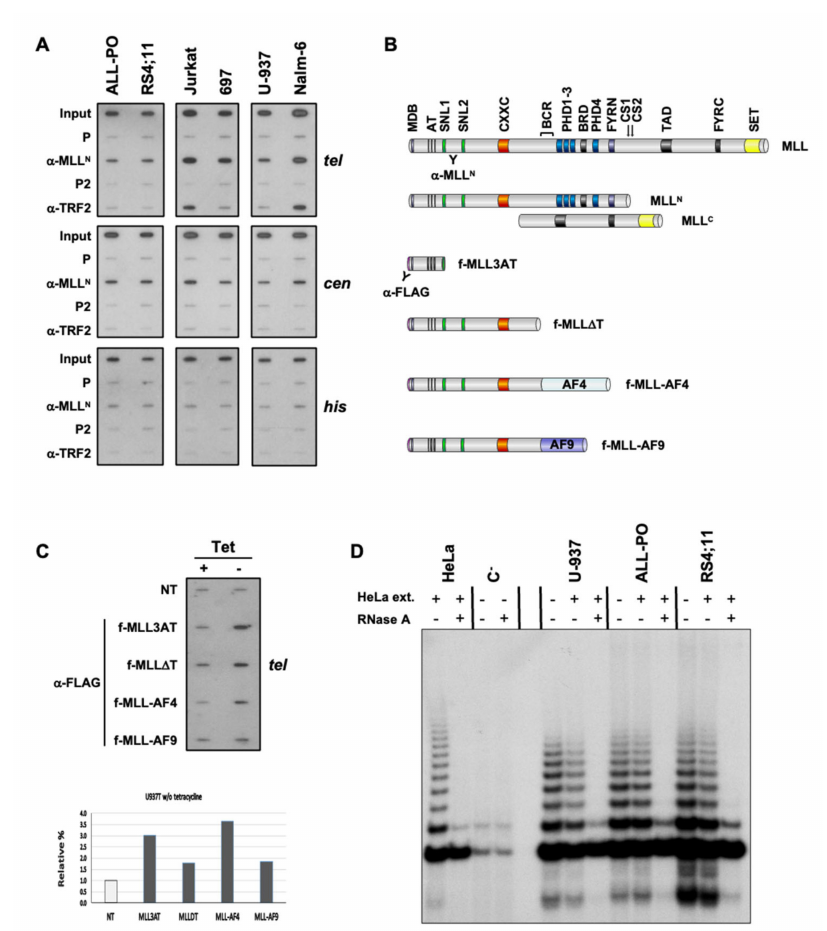
Figure 1. Telomeric chromatin binding of MLL proteins and telomerase activity in MLL -r ALL. ( A ) Representative ChIP analysis of MLL -r pre-B-ALL (ALL-PO and RS4;11) and non- MLL -r pre-B- ALL (Nalm-6 and 697), T-ALL (Jurkat), and AML (U-937) cell lines. Chromatin was immunopre- cipitated using polyclonal antibodies against MLL N (see MLL proteins schematic on panel B for epitope localization) and TRF2 proteins, blotted and hybridized sequentially with 32 P-end-labeled oligonucleotides specific for telomeric DNA repeats ( tel ) and histones coding sequences ( his ), and a human α − satellite DNA sequence specific for the centromere of every human chromosome ( cen ). The input signal consists of 2% of the amount of chromatin used with each immunoprecipitation. P and P2 are pre-bleed sera, respectively, of α -MLL N and α -TRF2 pAbs. ( B ) Schematic of endogenous and ectopic MLL proteins analyzed by telomeric ChIP. MDB: Menin binding domain; AT: AT hook motifs; SNL1/2: Speckled nuclear localization domains; CXXC: CXXC zinc finger domain; BCR: Break- point cluster region; PHD1-4: Plant homeodomain fingers; BRD: Bromodomain; FYRN/C: “FY-rich” domain N- and C-terminal; CS1/2: Taspase 1 endopeptidase cleavage sites; TAD: Transactivation domain; SET: Su(var)3-9, Enhancer-of-zeste, and Trithorax domain. ( C ) Empty vector-transfected (NT) U-937 cells and clones conditionally expressing FLAG-tagged MLL-AF4 and MLL-AF9 fusion proteins and N-terminal fragments retaining 410 (MLL3AT) and 1436 (MLL ∆ T) amino acids of MLL N under tetracycline ( Tet )-off conditions were grown in the presence (+) or absence (–) of 1 µ g/mL Tet. An equal number of cells were then analyzed by ChIP for conditionally expressed MLL protein binding to telomeric DNA repeats ( tel ) using α -FLAG pAbs. We quantified MLL protein signals by ImageJ densitometry analysis, normalized each (–) Tet signal towards the corresponding (+) Tet signal (dark columns), and expressed them relative to the NT signal (light column). ( D ) Telomere repeats amplification protocol (TRAP) analysis of non- MLL -r U-937, and MLL -r ALL-PO and RS4;11 cell lines. All three cell lines revealed telomerase activity for telomere length maintenance. HeLa cell extract and treatment with RNase were used as